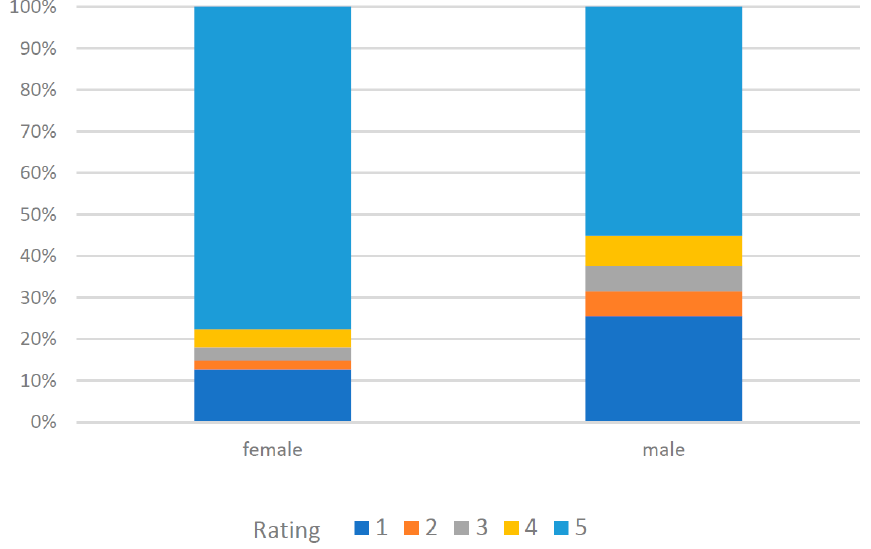
Figure 6. Distribution of rating of car-sharing service by gender.